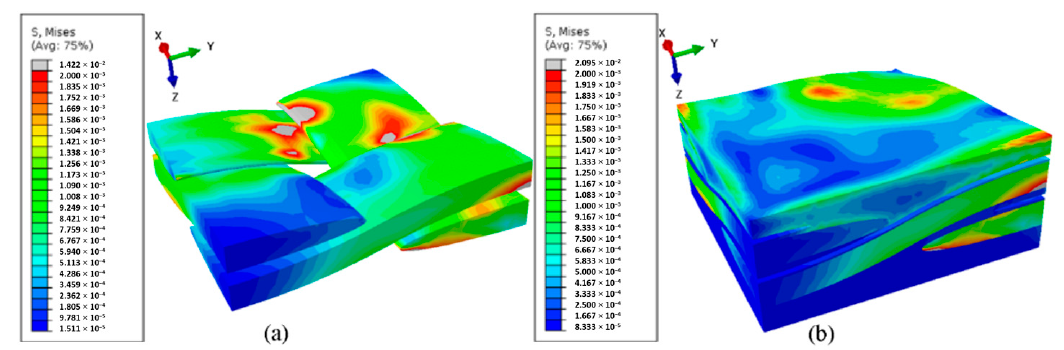
Figure 16. Representative volumetric models (RVE) unit cell load results: ( a ) a numerical model of the volume cell, ( b ) a geometric model of the elementary cell.